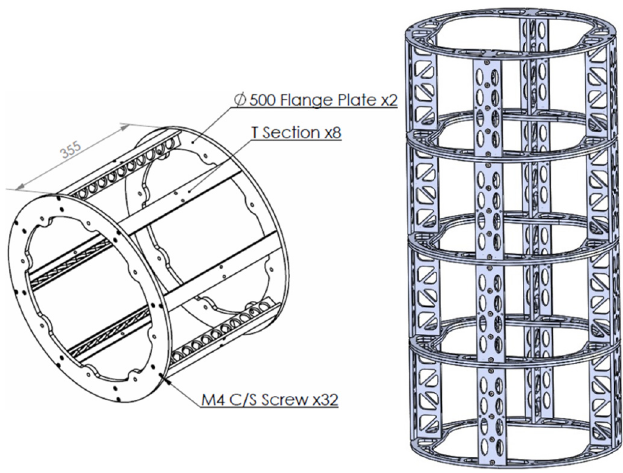
Fig. 3. Design of assembly structure.